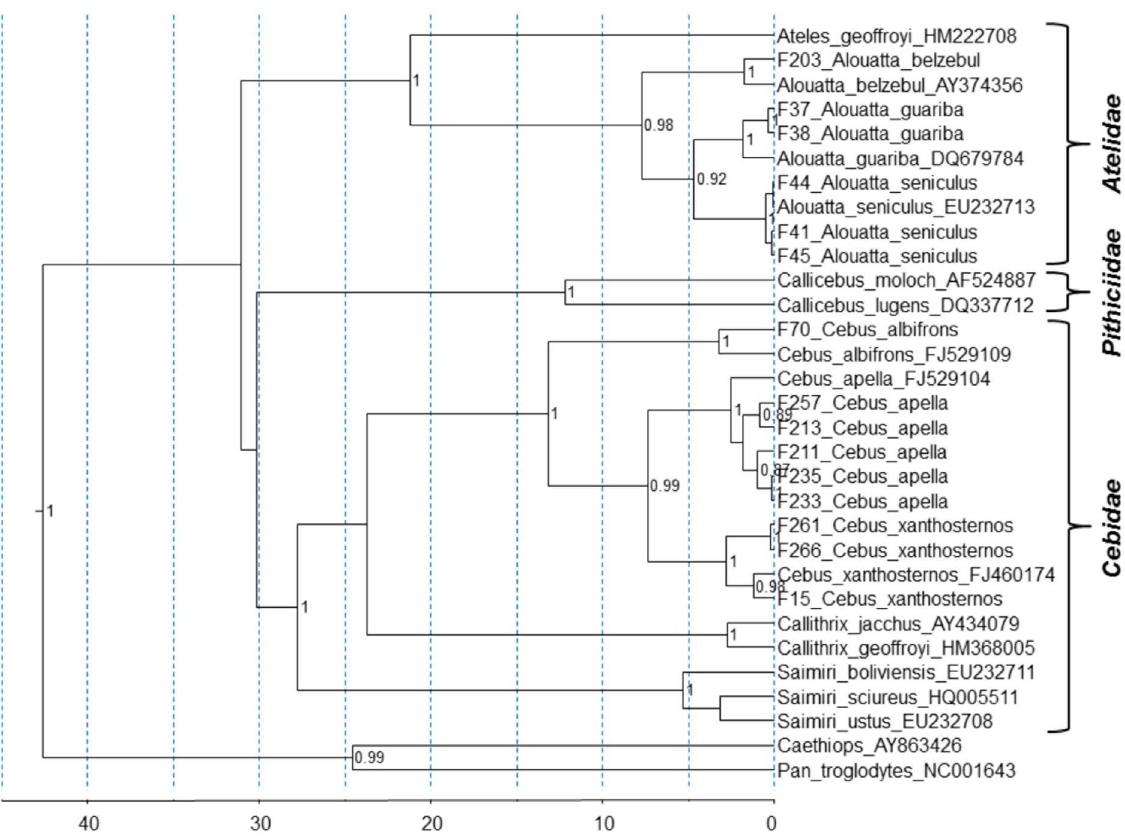
Figure 2. Taxonomical classification of SFV-positive NWP specimens based on phylogenetic inference of 500-bp cytochrome B ( cytB ) sequences. GenBank accession numbers of reference ctyB sequences are provided. Topology and divergence dates were inferred using a relaxed molecular clock and a Yule tree prior using BEAST v1.6.2. X axis is in millions of years. Posterior probabilities . 0.8 are provided at nodes.